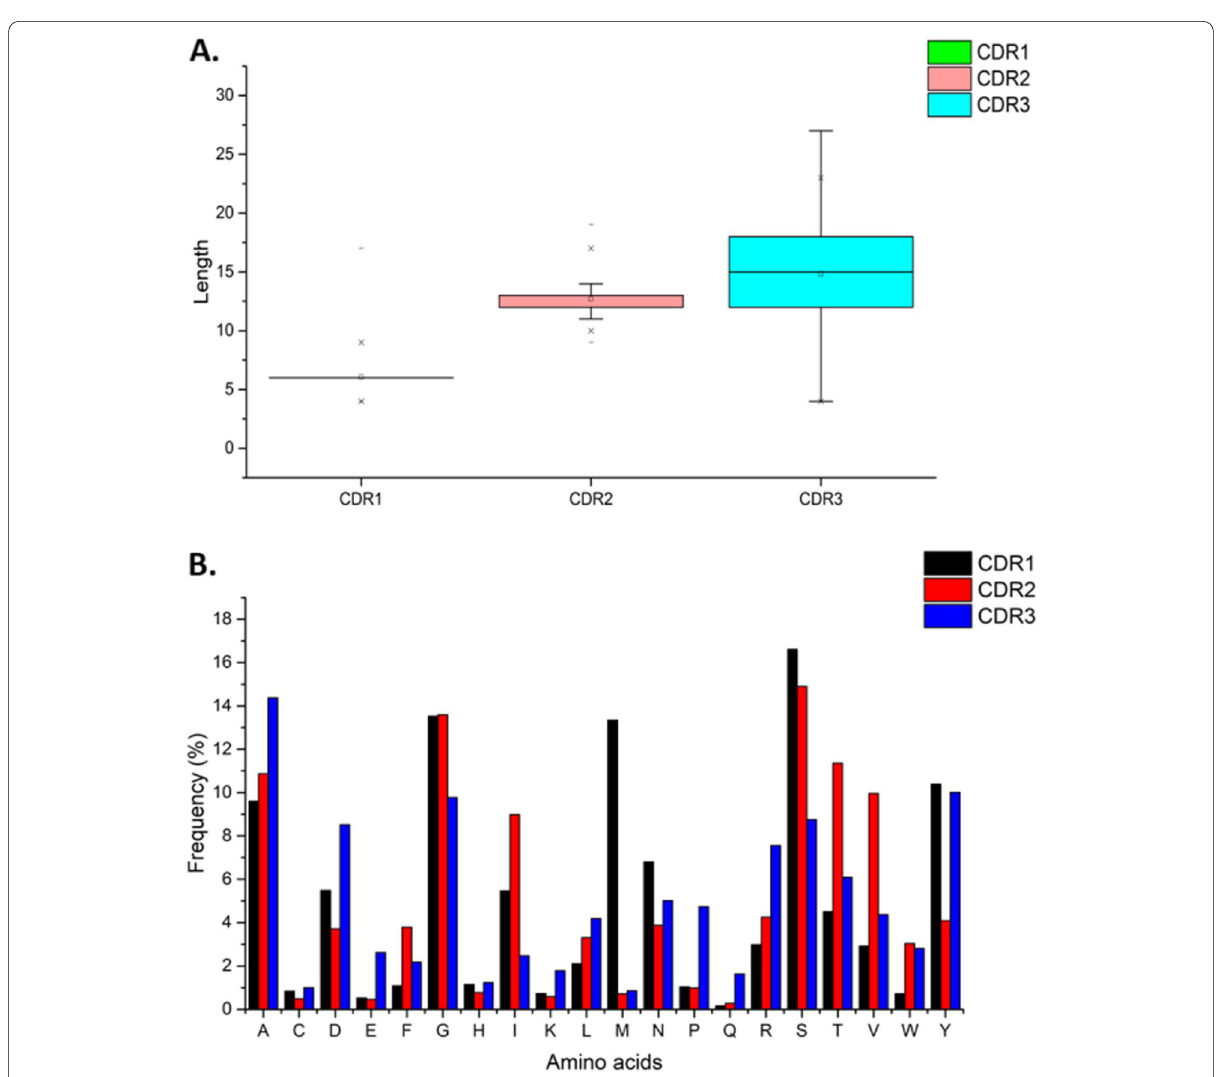
Fig. 2 Distribution of sequence lengths and amino acid composition of CDRs from Nbs. A CDR length. B Amino acid